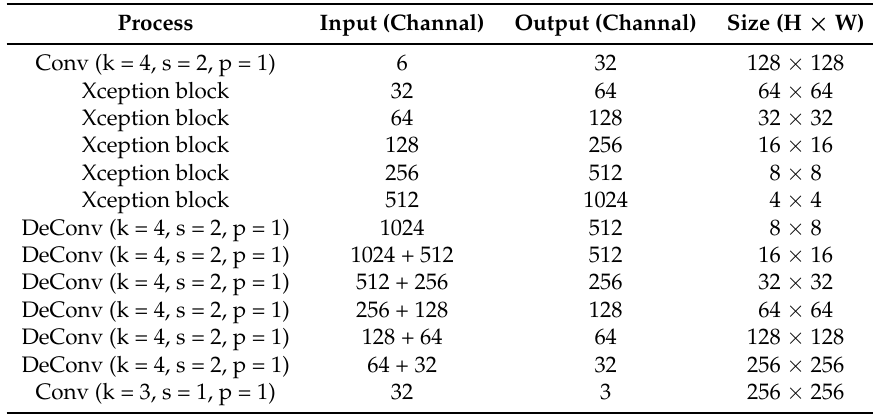
Table 1. Architecture of hidden